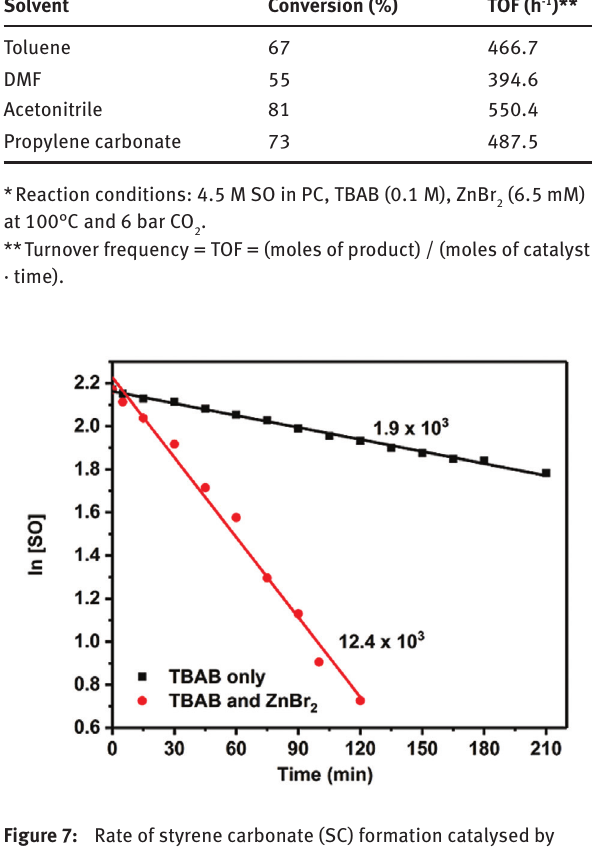
(reaction conditions: Solvent-free SO, 2 2